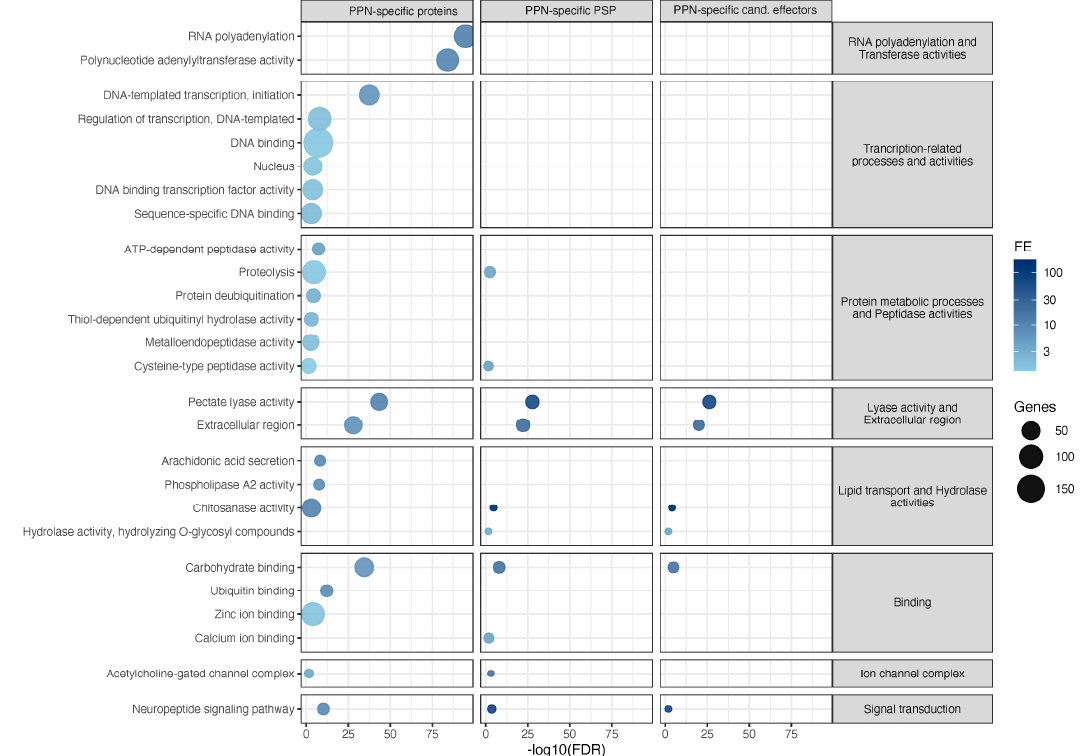
Figure 2. Enriched GO terms in plant-parasitic-specific proteins, including putative secreted proteins and candidate effectors. Only GO terms with FDR <0.05 and at least four genes in the node are represented. Correlated terms are grouped together and represented by more general terms (right-side grey rectangles). Bubble sizes are according to the number of genes annotated with a specific GO term. Bubble positions are according to − log10 (FDR) (false discovery rate) values. The darkness level of bubble colors is according to GO terms fold-enrichment (FE) values (see methods).